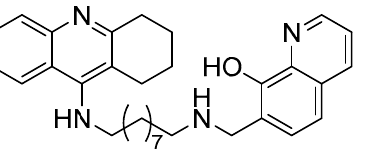
Figure 13. Hybrid of tacrine-clioquinol.